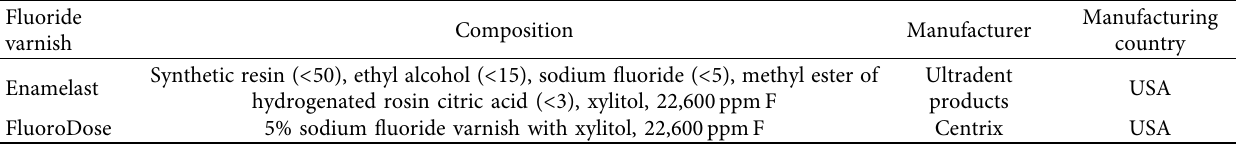
Table 1: Composition of fluoride varnishes used in this